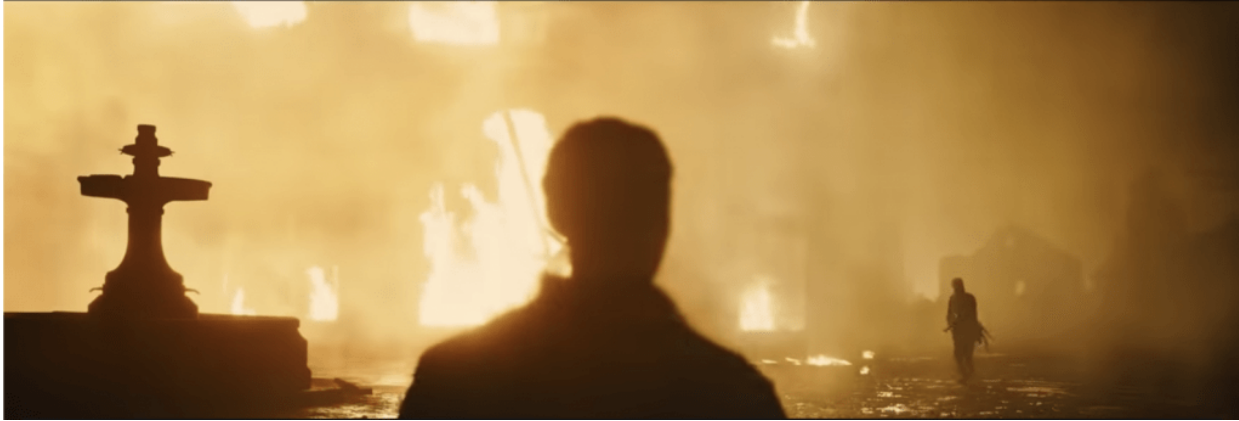
Arts 2021 , 10 , x FOR PEER REVIEW 29 of 32 Figure 16. They raise their weapon, their intentions unclear. (Screenshot created by author). Figure 16. They raise their weapon, their intentions unclear. (Screenshot created by author). Figure 16. They raise their weapon, their intentions unclear. (Screenshot created by author).